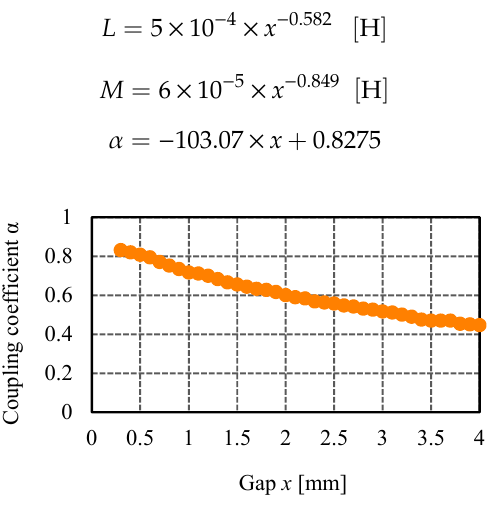
Figure 9. The measured value of the coupling coefficient α to the gap x .